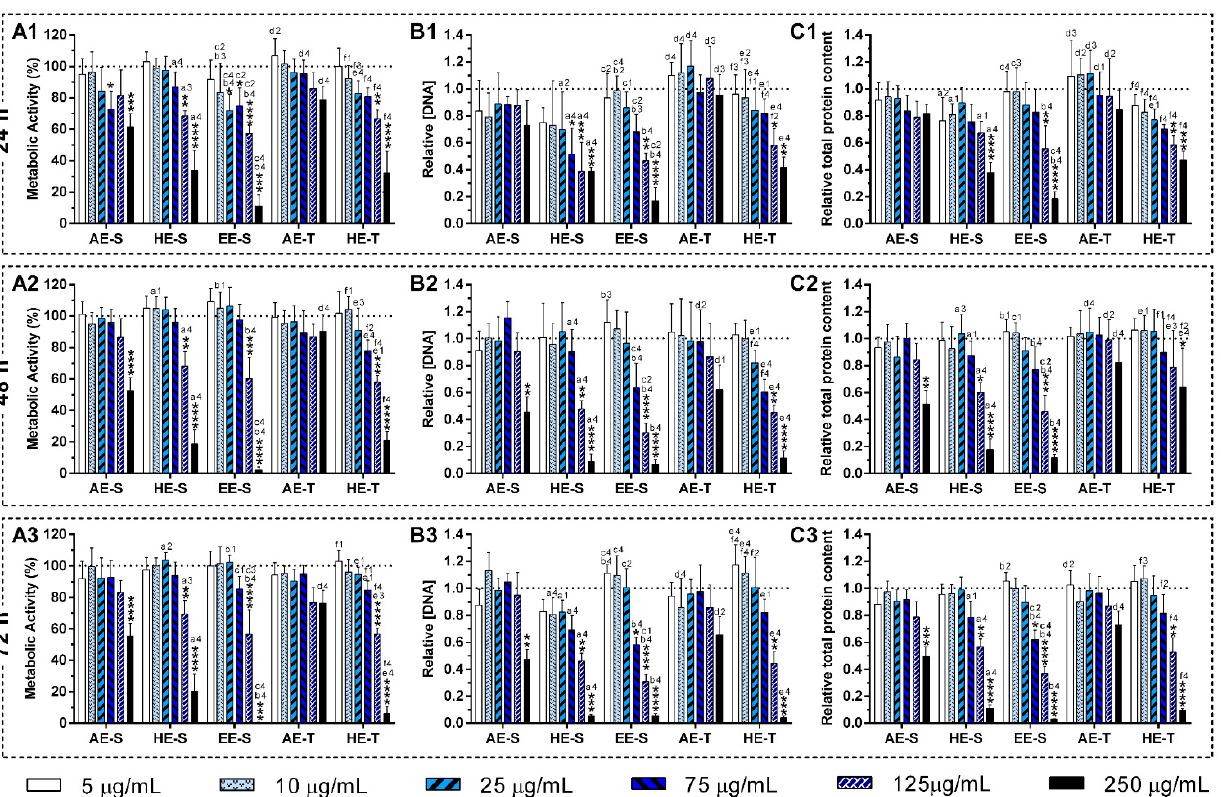
Figure 5. Metabolic activity ( A ), relative DNA concentration ( B ) and relative total protein content ( C ) of the L929 cell line in the presence of different concentrations of the Salvia officinalis extracts over 24 h (A1, B1, and C1), 48 h (A2, B2, and C2), and 72 h (A3, C3 and B3) of culture. The dotted line represents the nontreated condition (0 µg/mL) for each assay. Statistically significant differences are * ( p < 0.0466), ** ( p < 0.0093), *** ( p < 0.0010), and **** ( p < 0.0001) in comparison with the negative control (0 mg/mL) for each different Salvia officinalis extracts, and 1 ( p < 0.0496), 2 ( p < 0.0085), 3 ( p < 0.0009), and 4 ( p < 0.0001) in comparison with a (AE-S vs. HE-S), b (AE-S vs. EE-S), c (HE-S vs. EE-S), d (AE-S vs. AE-T), e (HE-S vs. HE-T), and f (AE-T vs. HE-T). AE: aqueous extracts; HE: hydroethanolic extracts; EE: ethanolic extracts; S: soxhlet extraction; T: traditional extraction.